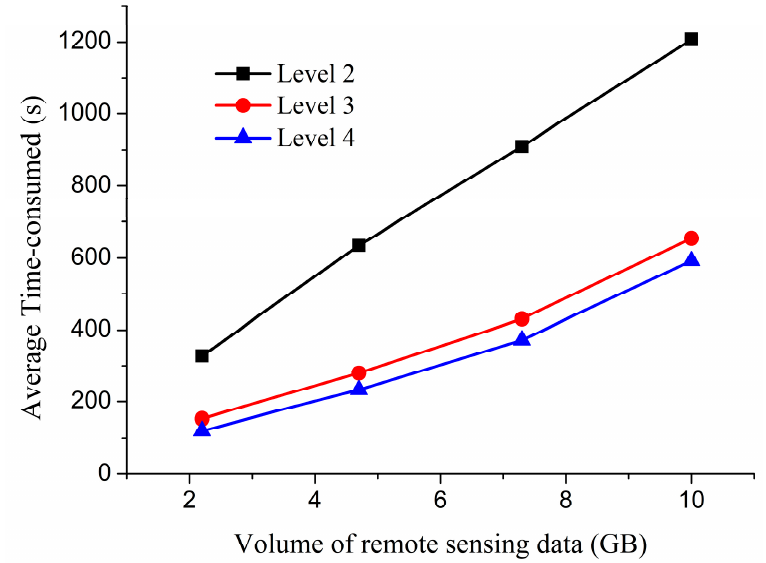
Figure 9. The result of storage experiment with different Level on SSI model.